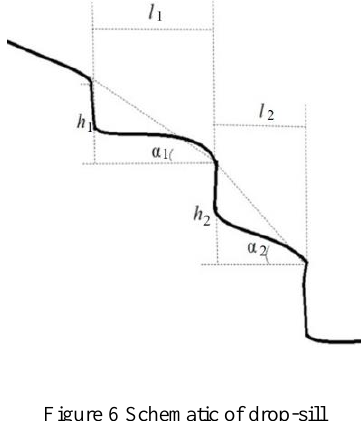
Figure 6 Schematic of